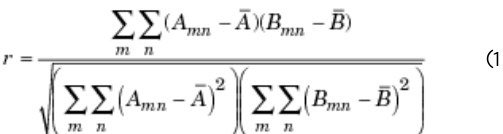
Figure 6. Monochrome of image 1 with translation vectors for image 5, calculated at 150 positions in a 15x10 grid.